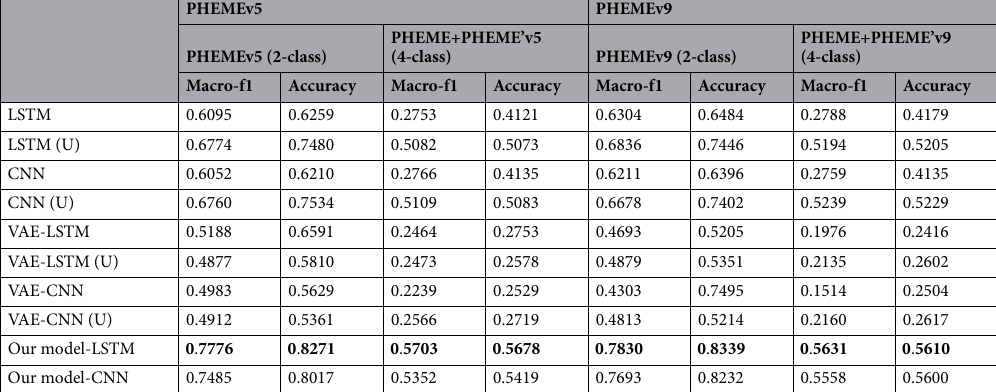
Table 5. Marco-f1 and accuracy comparison between our model and baselines on the extended 4-class experiments of rumor detection task on PHEME dataset. U indicates that the model is trained on PHEME+PHEME’, otherwise it is train on original PHEME dataset. All models are tested on PHEME ( R / N ) ′ ′ and PHEME+PHEME’ ( R / N / R / N ). The best results are marked in bold.